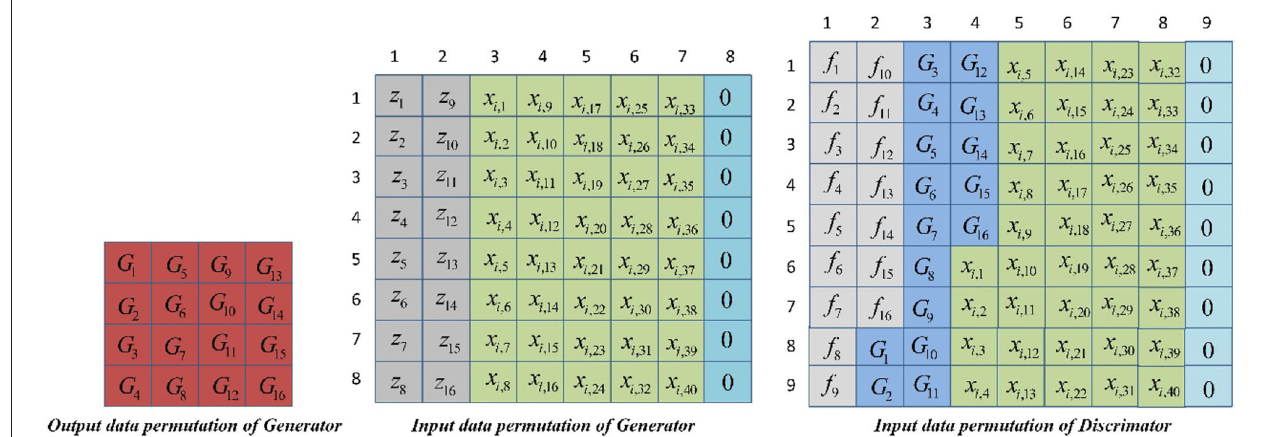
FIGURE 6 | Data arrangement of generator and discriminator.